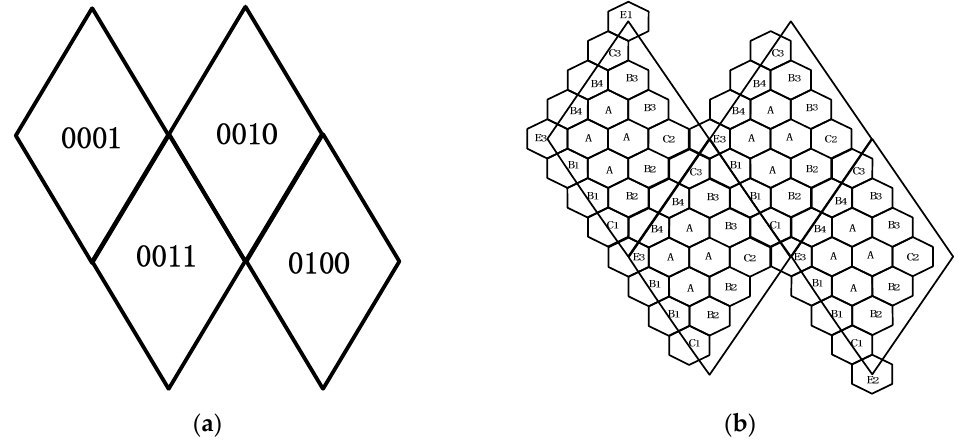
Figure 22. Octahedral planar expansion and hexagonal cell classification. ( a ) Basic diamond code of octahedron; ( b ) Octahedral hexagonal cell